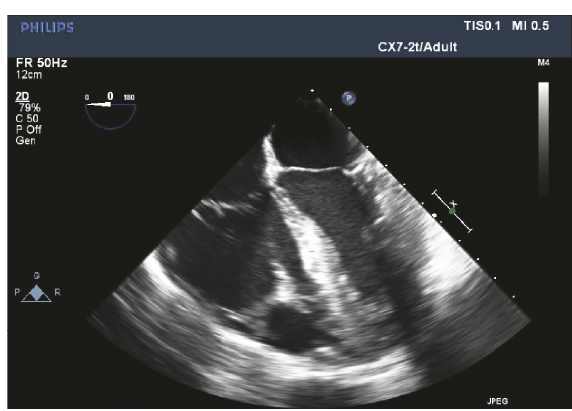
Figure 1: TEE mid-esophageal 4 chamber view showing dilated RV, RV end-diastolic diameter 48